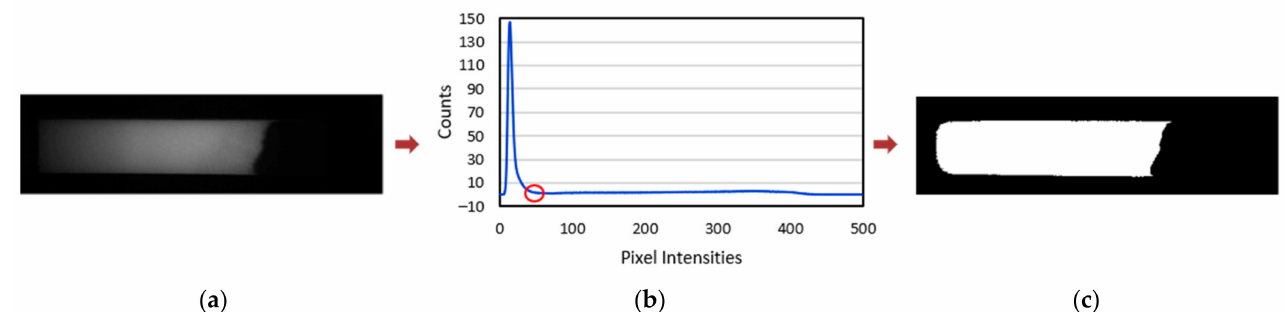
Figure 4. ( a ) Sample image frame captured during the flow process. ( b ) Corresponding histogram plot indicating the valley considered for thresholding. ( c ) The resulting binary map obtained from the global thresholding process.